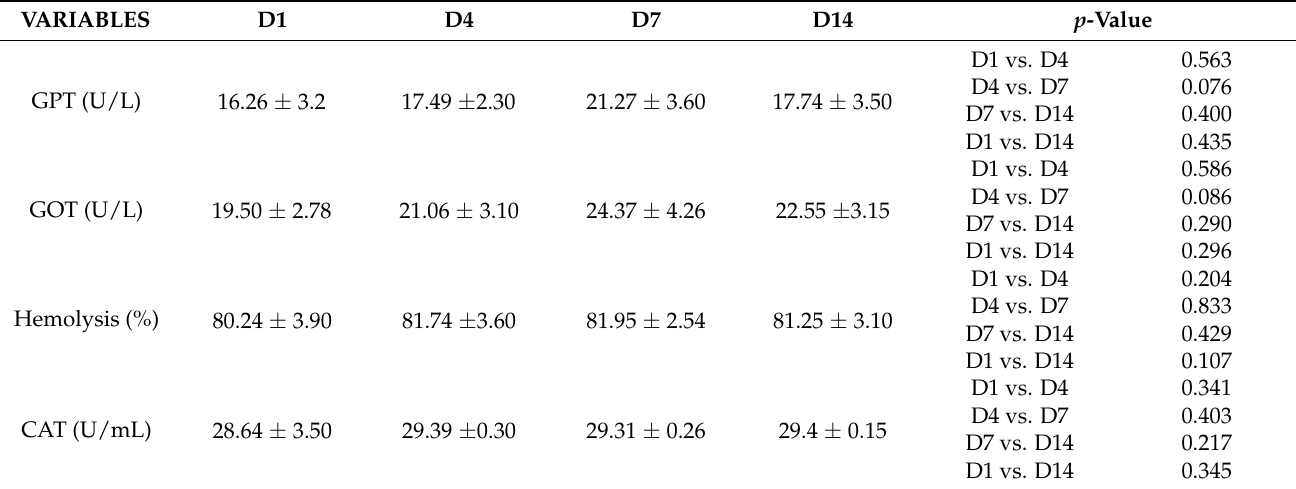
Table 3. Biomarkers without statistically significant